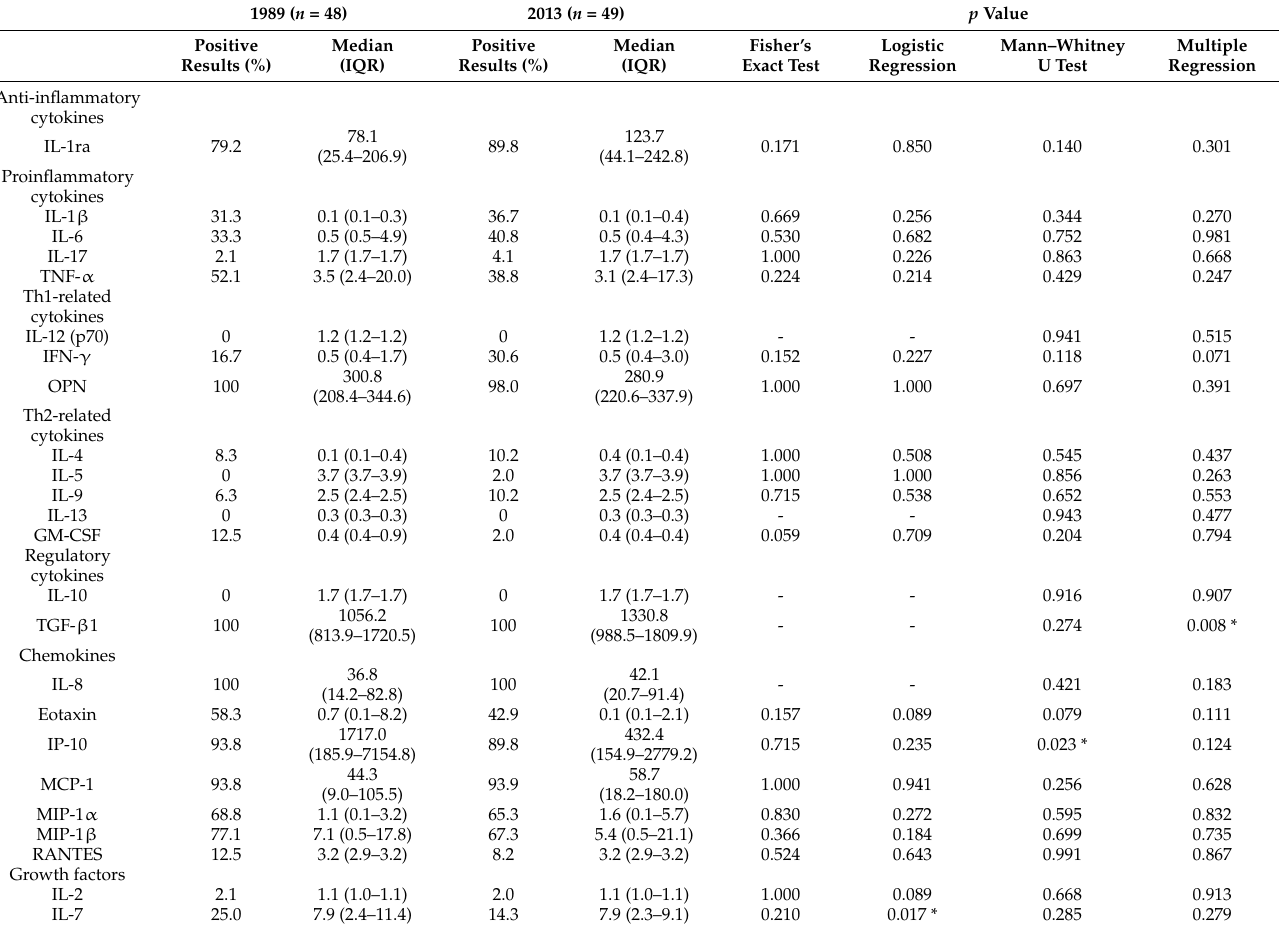
Table 3. Cytokine profile in the MM